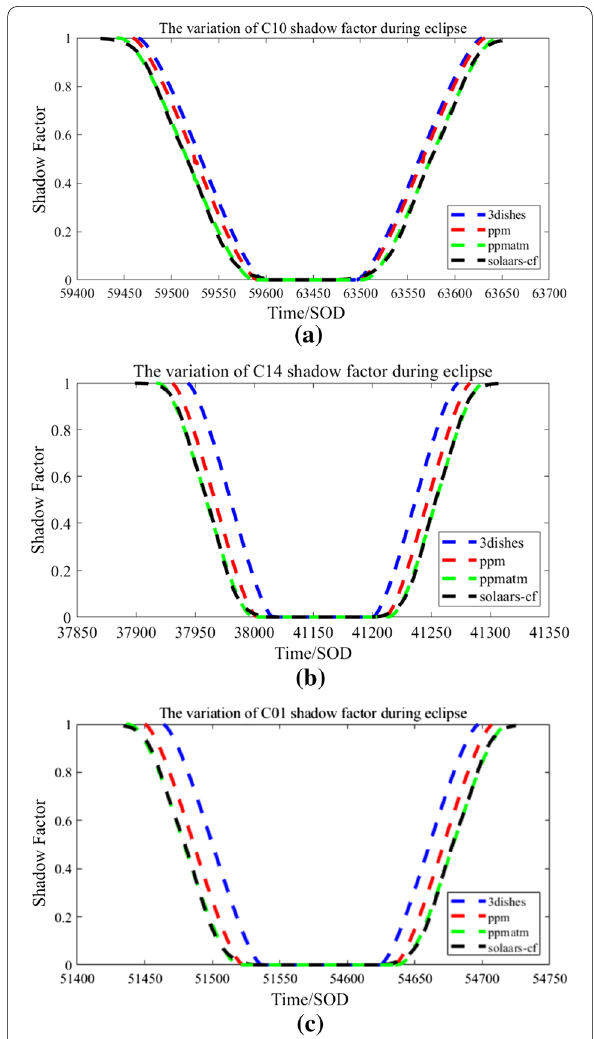
Fig. 6 a Shadow factors for satellite C10 (IGSO) in 2019/007. b Shadow factors for satellite C14 (MEO) in 2019/060. c Shadow factors for satellite C01 (GEO) in 2019/069